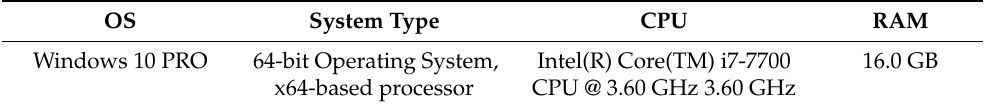
Table 6. Testing environment parameters.